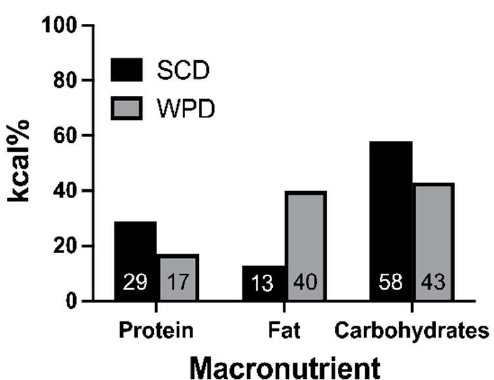
Figure 3. Macronutrient kcal/gram % of experimental (WPD) and control (SCD) diets. WPD = west- ern pattern diet; SCD = standard chow diet. pattern diet; SCD = standard chow